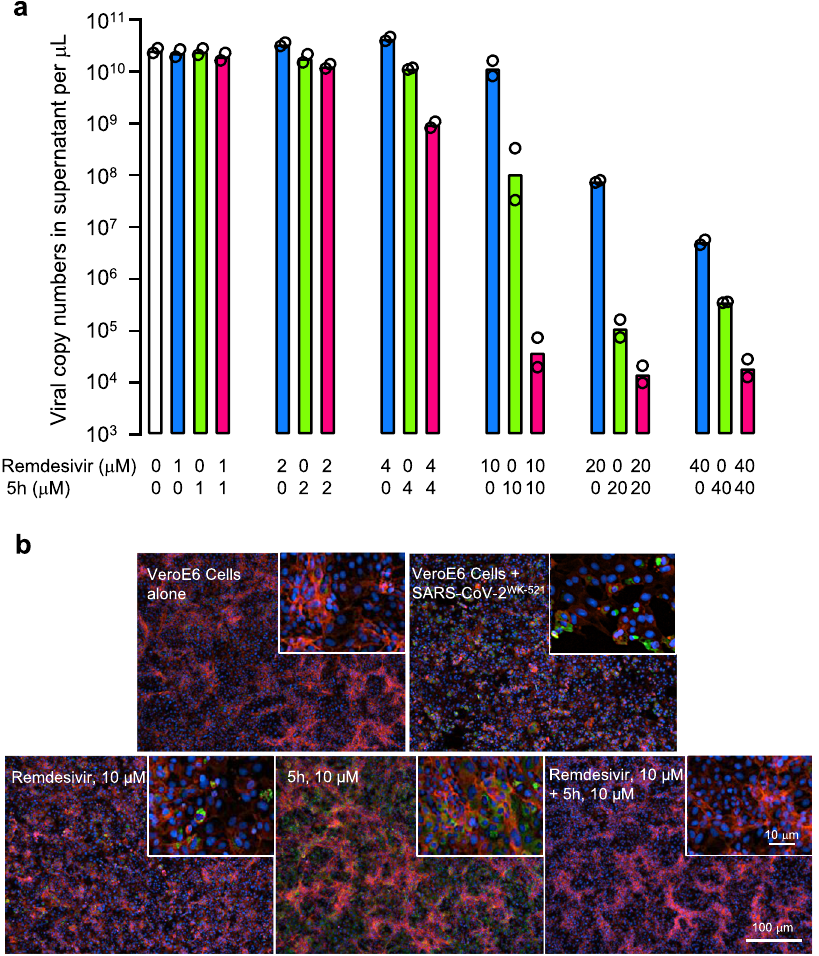
Fig. 5 Compound 5h combined with remdesivir does not permit viral breakthrough. VeroE6 cells were exposed with SARS-CoV-2 WK-521 for 1 h, the virus was washed out, and the virus-exposed cells were cultured for 3 days in the presence of compounds. a Viral RNA copy numbers in the culture supernatants were determined using RNA-qPCR. The numbers of viral RNA copy were more signi fi cantly reduced in the combination of 5h and remdesivir (each at 4, 10, 20, and 40 µ M) than 5h or remdesivir alone. The mean EC 50 values of 5h and remdesivir determined with this set of the data were 4.0 and 9.0 µ M, respectively. The fi gure was generated with GraphPad Prism 9. Bars indicate geometric mean ( n = 2). b Representative images of fl uorescent immunocytochemistry data from two independently conducted experiments are shown. SARS-CoV-2 antigens, F-actin, and nuclei are indicated in green, red, and blue, respectively. Source data are provided as a Source Data fi